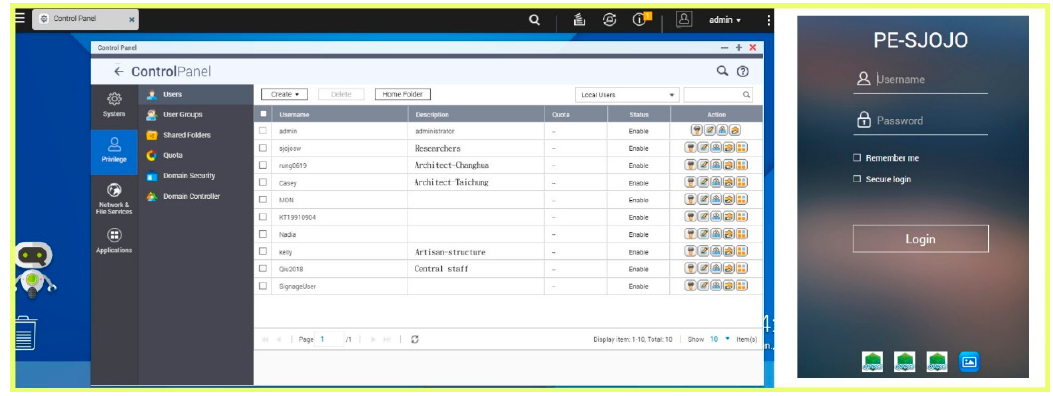
Figure 1. Permission setting page and system login page.